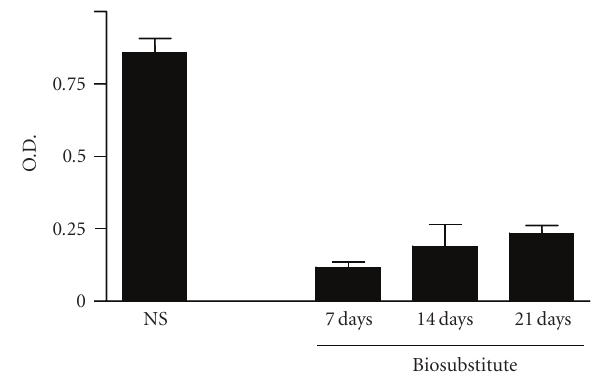
Figure 10: The MTT test was used to assess tissue viability in normal skin (NS) and biosubstitute. A NS sample was used as a positive control. The viability of skin substitute was analyzed at 7, 14 and 21 days after cell nebulization. A constant increase in the cell viability was observed over time, parallel to the growth and epidermal layer